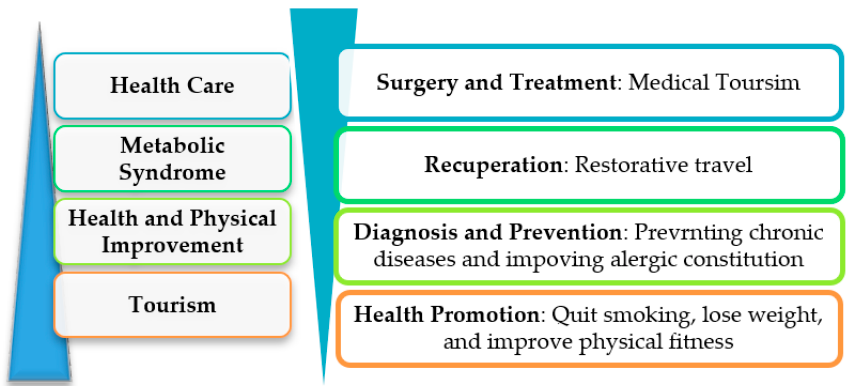
Figure 1. Categories of health tourism, including both leisure and medical aspects.